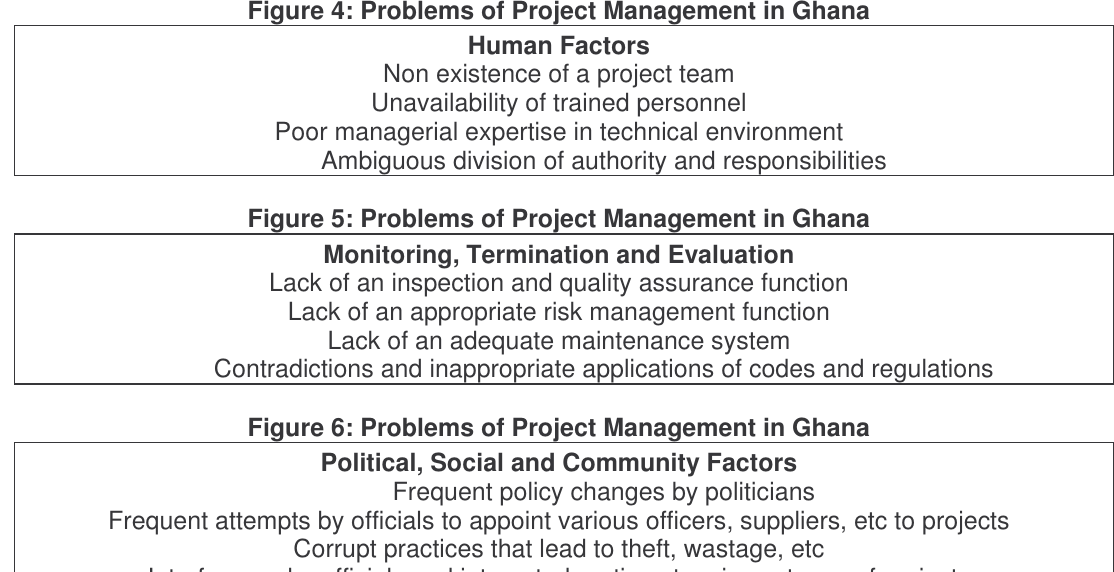
Figure 4: Problems of Project Management in Ghana